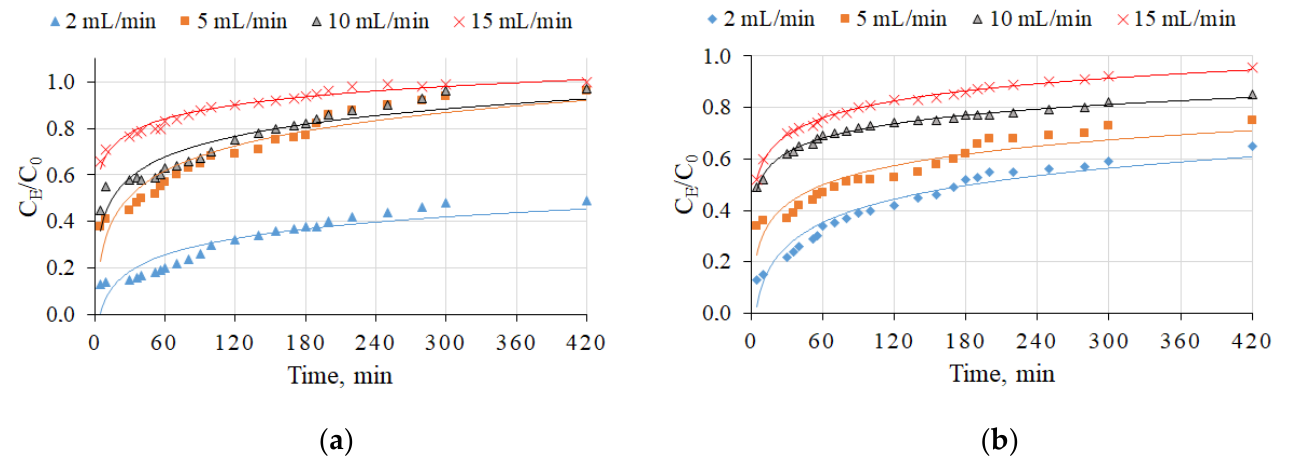
Figure 5. Influence of the flow rate on the breakthrough curves of total P ion sorption by straetlingite-based sorbents in wastewater from an open recirculation African catfish farming system: ( a ) S20 (according to the Table 1); ( b ) S30. The initial NH 4+ ion concentration in the synthetic aqueous solution was 10 mg/L and the filtration rates were 2, 5, 10, and 15